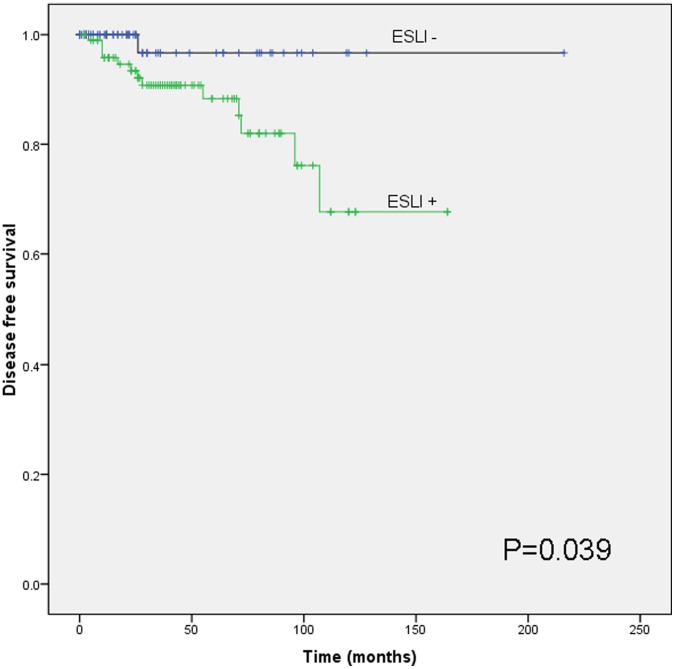
Kaplan Meier survival analysis for ESLI.Kaplan Meier survival analysis showing significant association with reduced disease free survival (DFS) in ESLI positive PTC patients (p = 0.039) with a mean DFS = 133 months compared to ESLI negative patients with a mean DFS = 210 months.